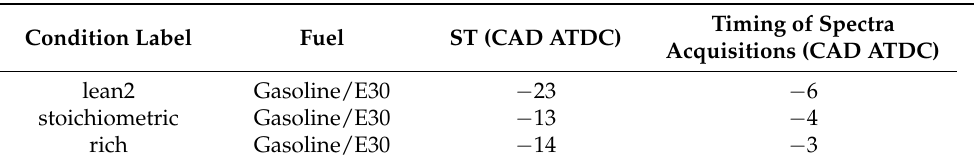
Table A1. Operating conditions for spectroscopic measurements (details of the engine parameters are reported in Table 4).